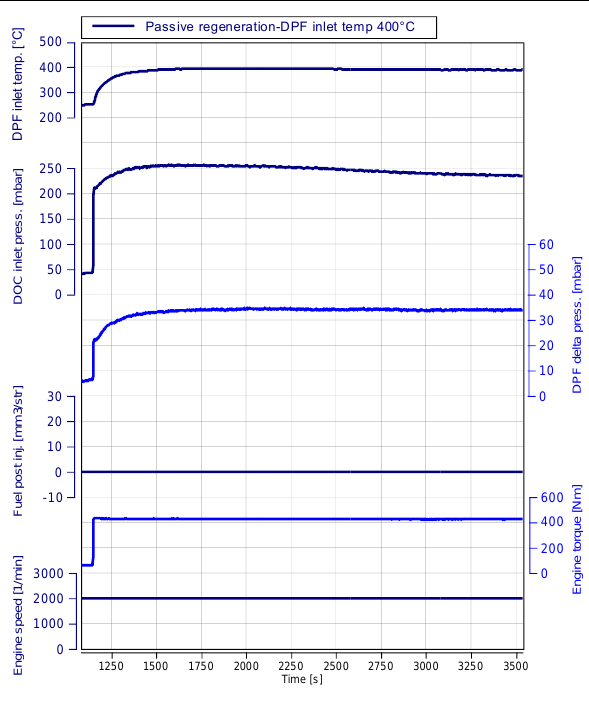
Fig. 12. Passive regeneration of the filter